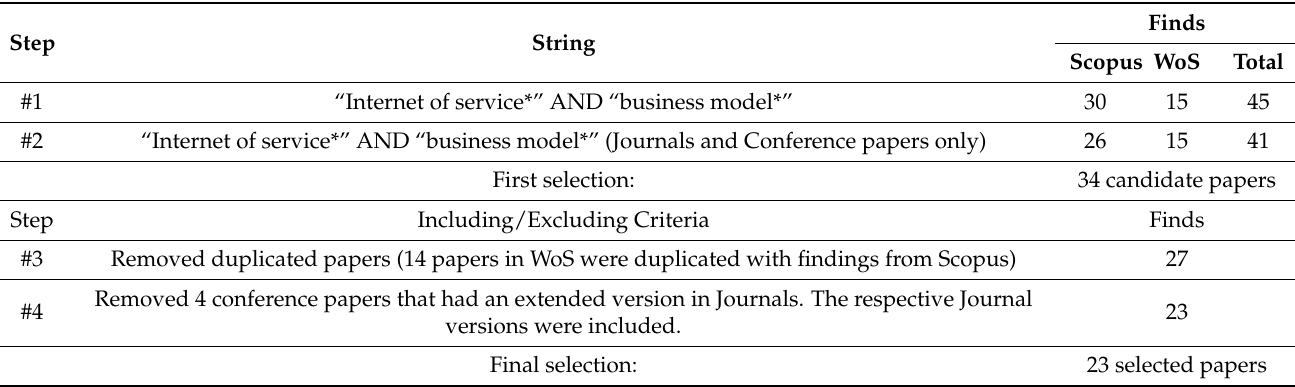
Table 1. Boolean strings and including/excluding criteria for the research.